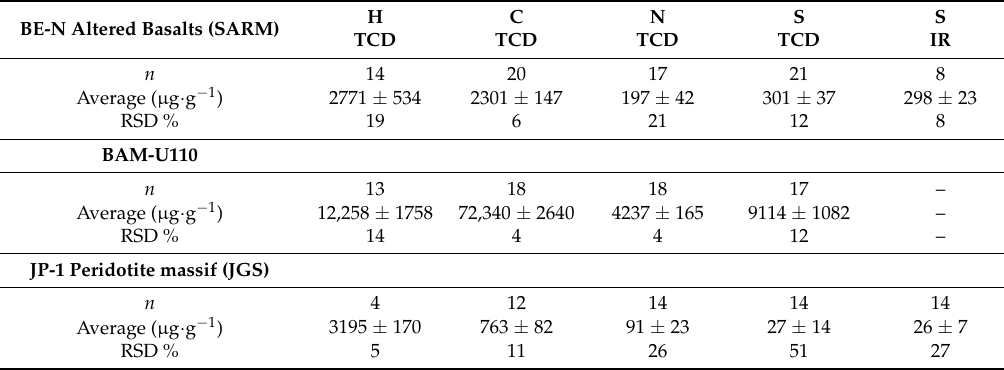
Table 2. Reference materials for CHNS